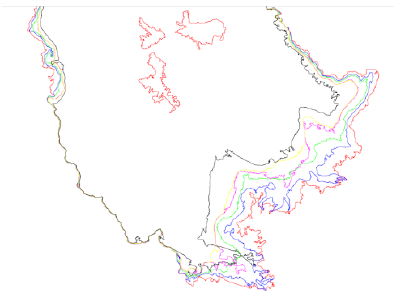
Fig. 3. The southern shorelines of the Lake